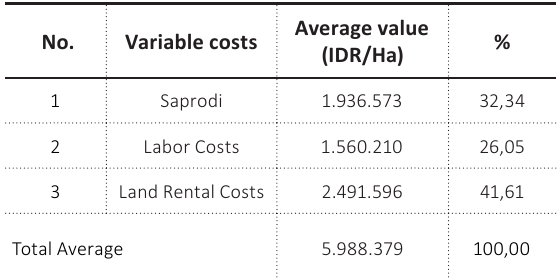
Table 1. Average variable costs of land per ha/planting